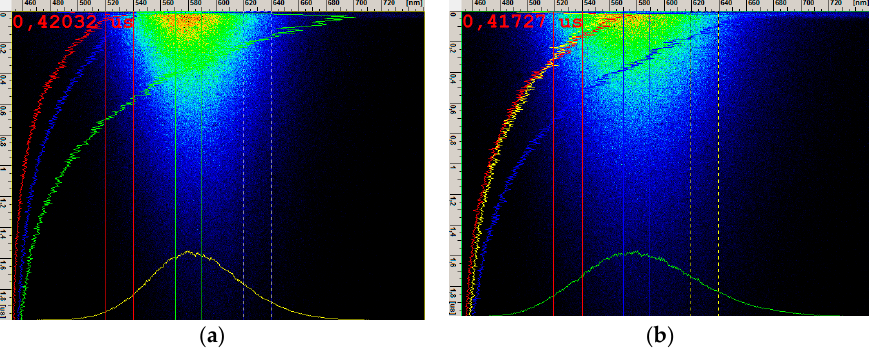
Figure 6. Time resolved luminescence spectra of Ca 0.8 Si 9.6 Al 2.4 O 0.8 N 15.2 :Eu 2+ (0.1 mol%) excited with 440 nm at temperature 10 K ( a ) and 500 K ( b ) the abscissa represents the wavelength , the ordinate time scale. The curves represent the spectra and the PL decays.